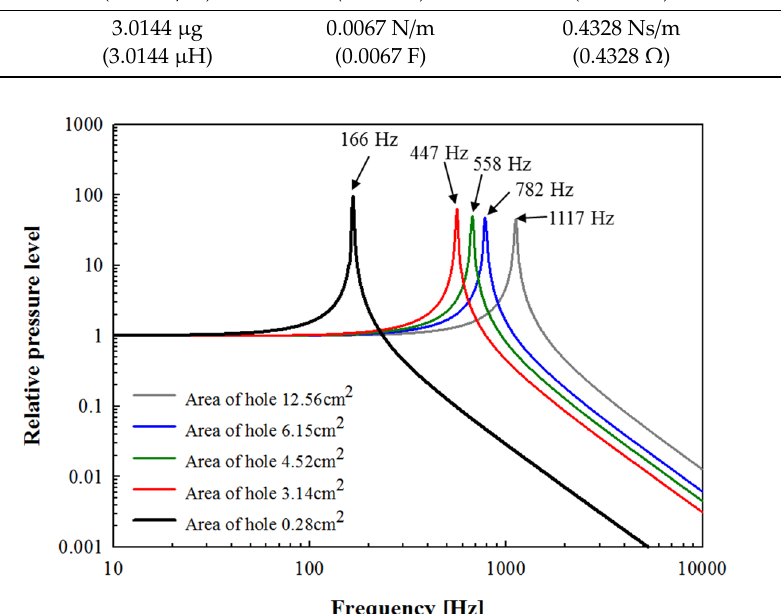
Figure 6. Simulation results for resonant frequency characteristics according to the equivalent circuit.